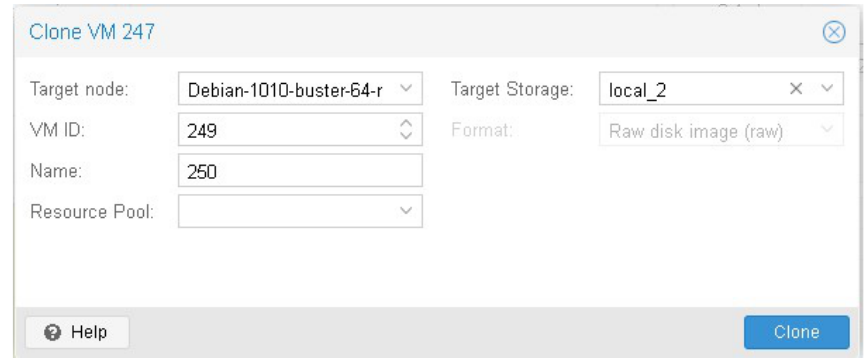
Figure 1: Creation of a new VM by a student through cloning of an existing